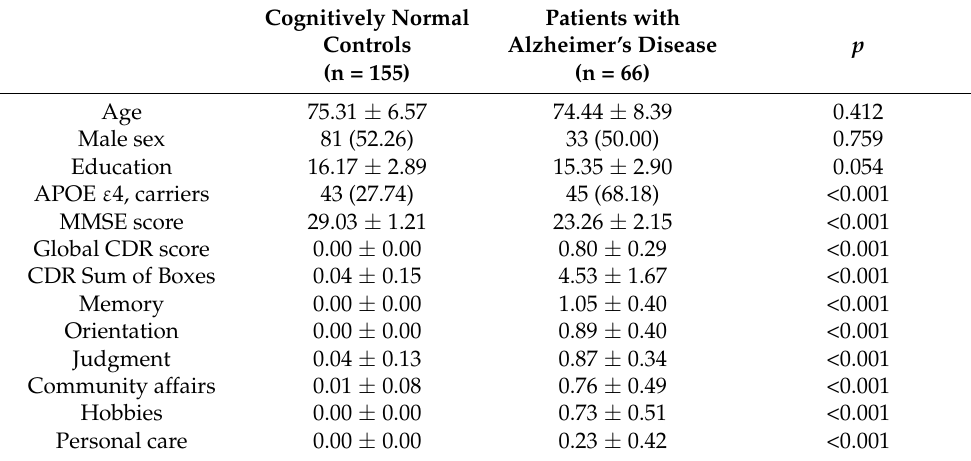
Table 1. Demographic and clinical assessments.